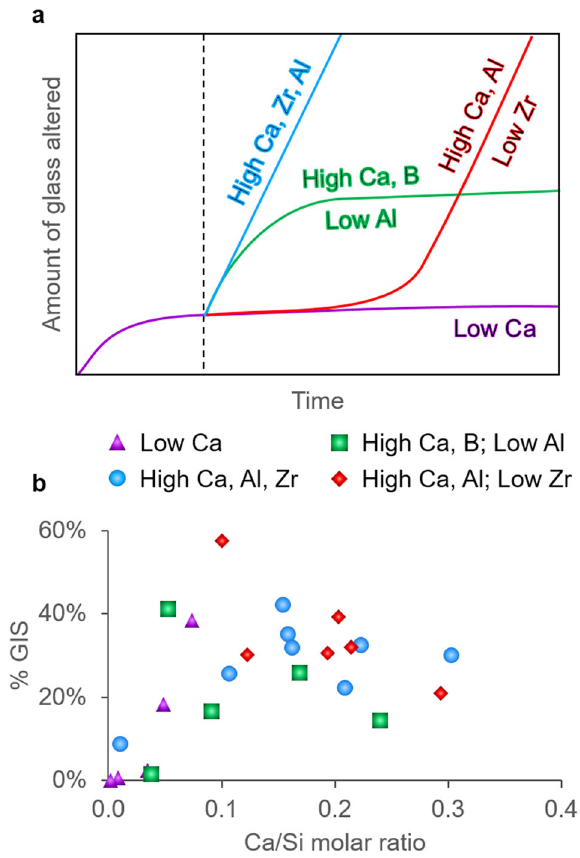
Fig. 2 Effect of Ca. a Qualitative response curves of eLAW glasses in dissolution studies performed in the presence of zeolite seeds, as reported by Crum et al. 32 . Seed addition (dashed vertical line) allows for glass responses to be assayed on a reasonable timeframe. Glasses are characterized and grouped according to their composi- tions: Type 1, low CaO (purple); Type 2, high CaO, Al 2 O 3 , ZrO 2 (blue); Type 3, high CaO, B 2 O 3 , and low Al 2 O 3 (green); and Type 4, high CaO, Al 2 O 3 , and low ZrO 2 (red). b Experimentally observed weight fraction of zeolite GIS phase in the product of bulk crystallization versus Ca/Si molar ratio in the initial synthesis mixtures designed to mimic eLAW glass conditions. Exact molar compositions and product phase information are presented in Supplementary Tables 2 and 5, respectively. Color coding of data points is based on the classi fi cation of each glass according to panel a , which corresponds to alteration responses for glasses with low CaO (purple triangles); high CaO, Al 2 O 3 , ZrO 2 (blue circles); high CaO, B 2 O 3 , and low Al 2 O 3 (green squares); and high CaO, Al 2 O 3 , and low ZrO 2 (red diamonds). Elemental forms rather than oxide forms are used in the fi gure for brevity. Panel a is recreated with permission adapted with permission from ref. 32 , Copyright 2021 by John Wiley and